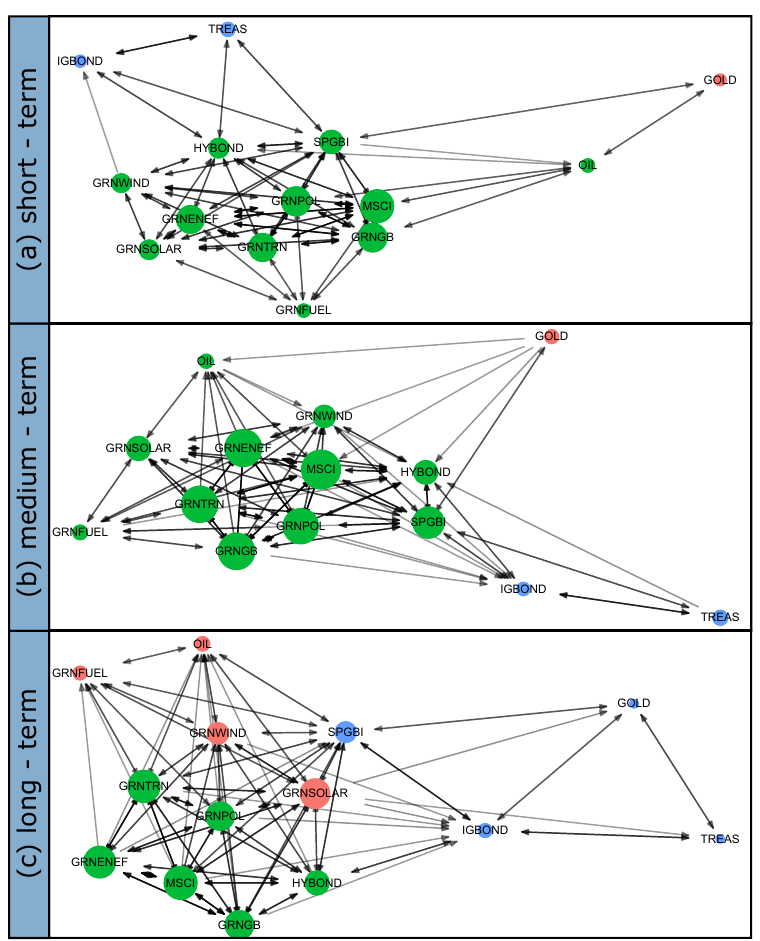
Figure 2. Wavelet coherence-based networks during the European sovereign debt crisis sub-period (from 13 October 2010 to 31 July 2012) for the three frequency bands considered. ( a ) short-term, between 2 and 5 days; ( b ) medium-term, between 5 and 22 days; ( c ) long-term, more than 22 days. Source: own elaboration using the R statistical software [65] together with packages wavScalo- gram [66], igraph [67], and ggraph